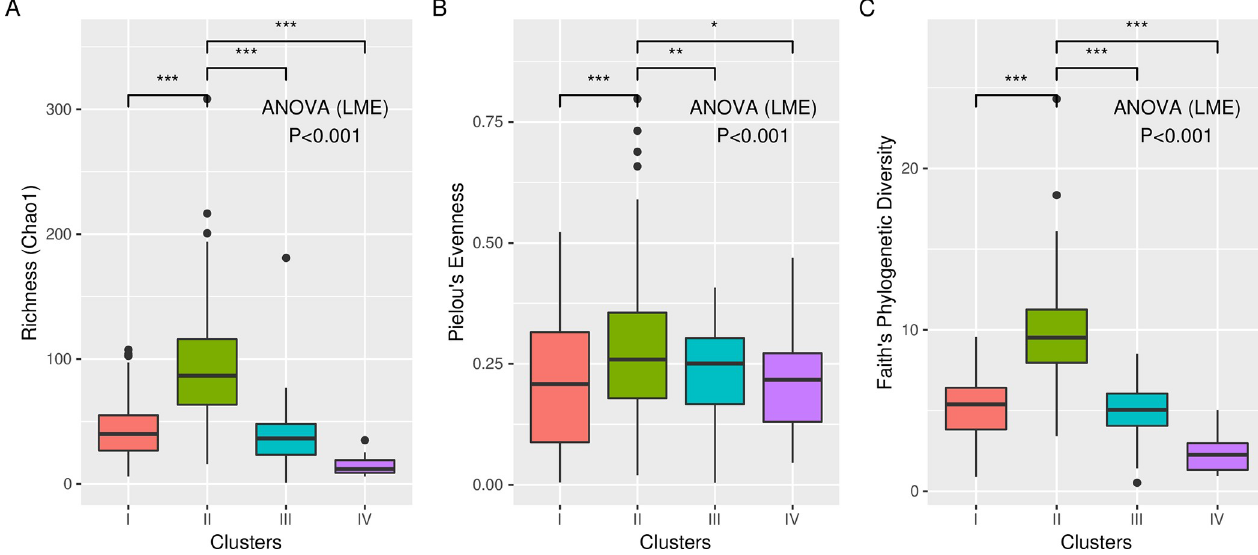
Fig 2. Community structure is significantly different in nasopharyngeal microbiota. Clusters are differentiated by A. richness, B. evenness and C. phylogenetic diversity, with cluster II exhibiting the greatest diversity across all three measures.